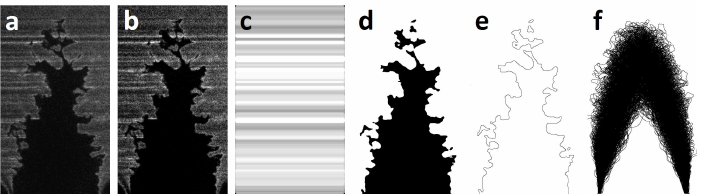
Figure 5. OH-PLIF image processing method for high pressure flame with a low signal-noise ratio. ( a ) Raw OH-PLIF image; ( b ) image with median filter; ( c ) the local threshold of image binaryzation; ( d ) the binary image; ( e ) the flame front (border of binary image); ( f ) flame brush. The flame shown above was operated under 1.0 MPa with a bulk inlet velocity of 3